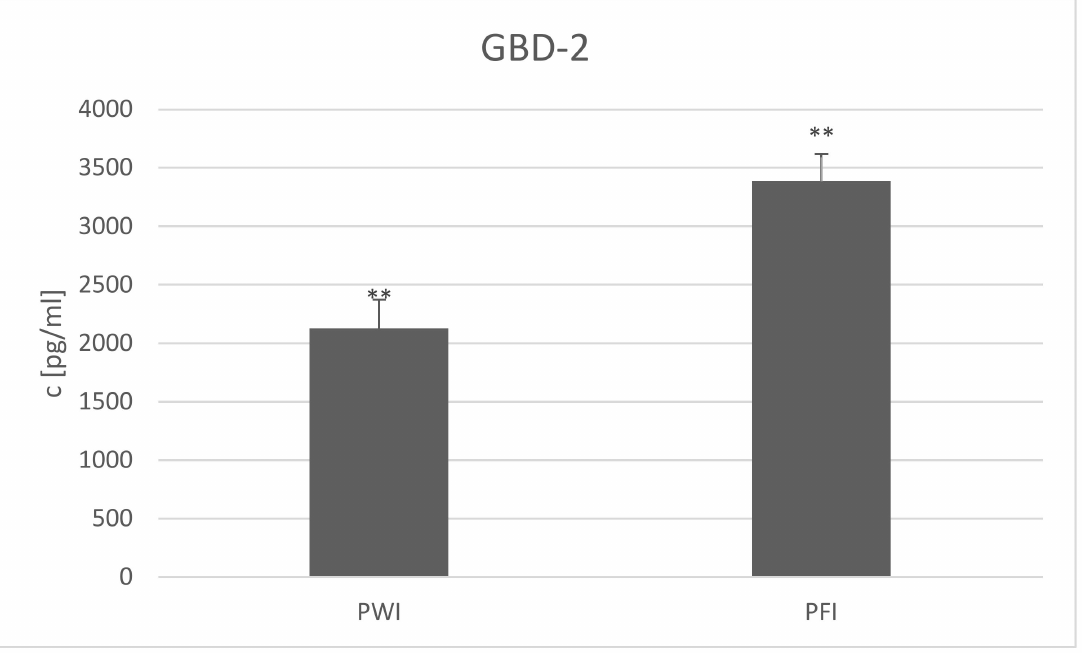
Figure 2. β -Defensin 2 (GBD-2) concentration (c) (presented as LSMEAN value with standard errors) in milk of PWI and PFI breeds from Herd Ie at the end of the experiment; PWI—Polish White Improved; PFI—Polish Fawn Improved; ** differences between breeds at p ≤